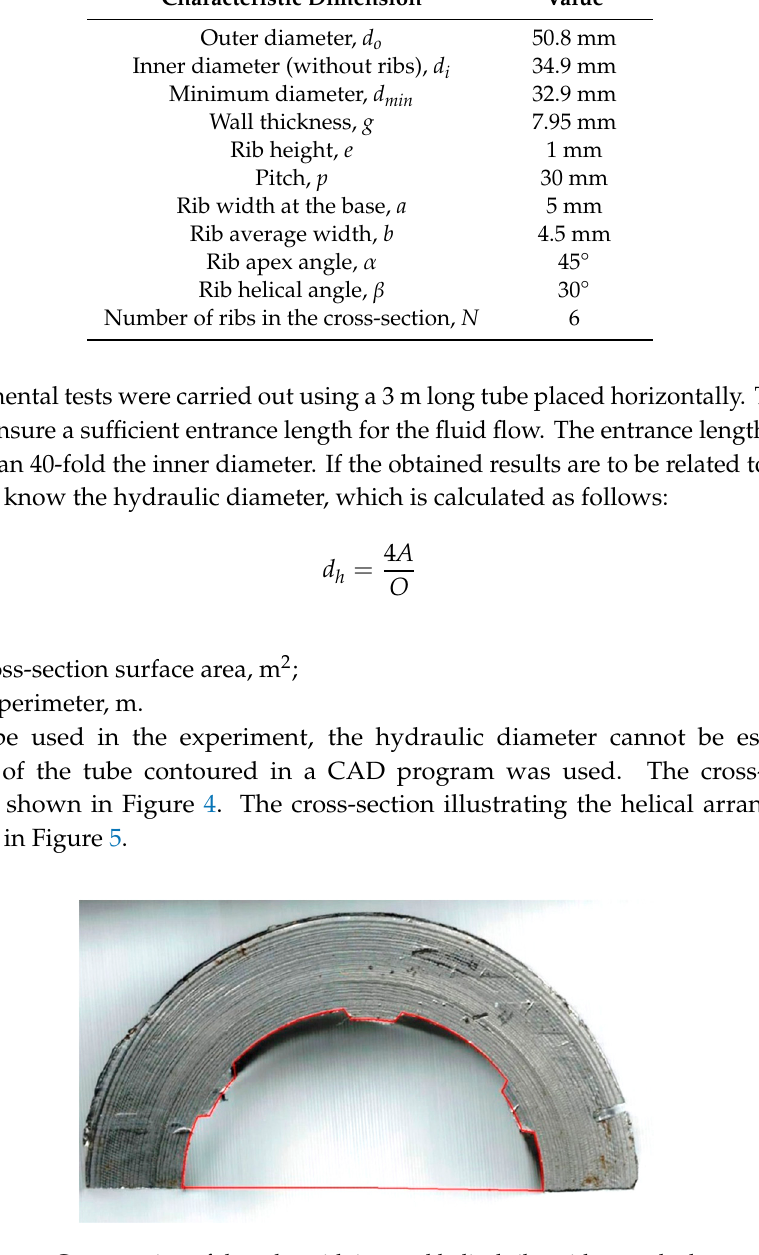
Figure 4. Cross-section of the tube with internal helical ribs with a marked contour.